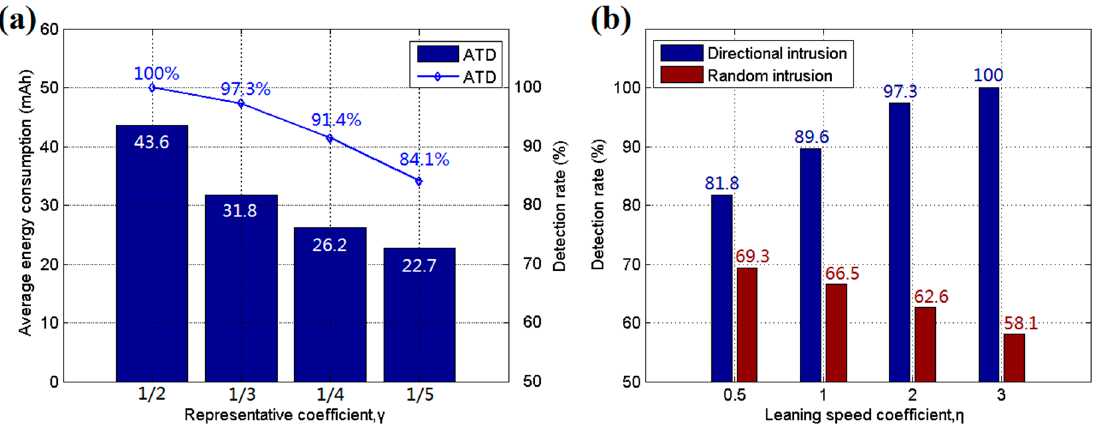
Figure 10. ( a ) Average energy consumption and detection rate for different representative coefficients γ ; and ( b ) detection rate for different learning speed coefficients η .